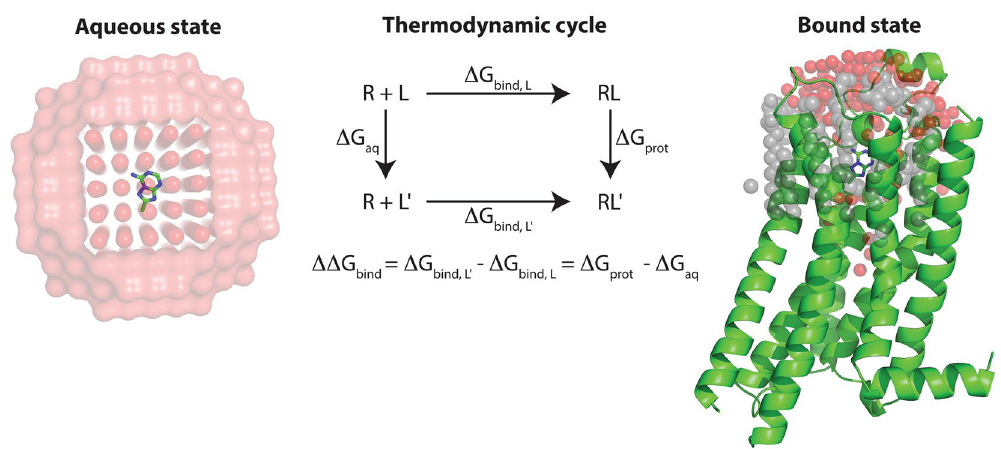
Figure 2. Thermodynamic cycle used to calculate relative free energies of binding ( ΔΔ G bind ) from MD simulations. Alchemical transformations of the ligands L and L’ were performed in aqueous solution ( Δ G aq , left panel) and bound to the receptor ( Δ G prot , right panel). The protein is shown as green cartoon and the ligand is depicted in sticks. Water molecules are shown as red spheres and membrane carbon atoms are represented by grey